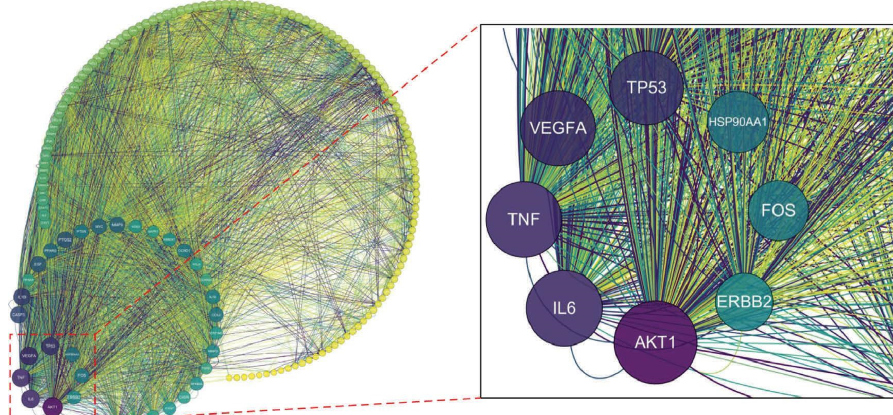
Figure 11: Te key targets were screened out according to DC, CC, and BC.